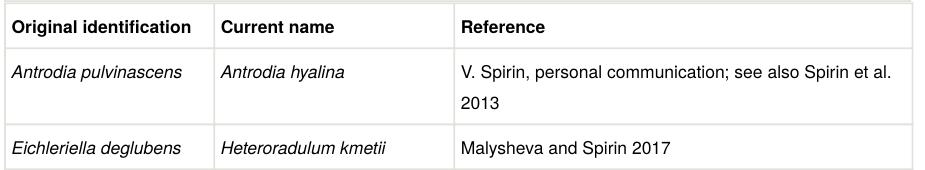
Re-identi fi cations of the eastern Ukrainian fungal collections based on recent taxonomical revisions. For all such species, the specimens were studied and cited personally by the authors of the new names (but see comment for Antrodia hyalina